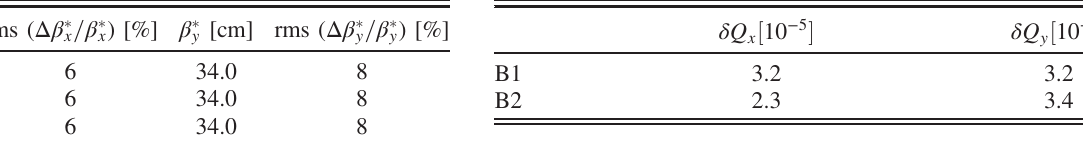
TABLE IV. Tune uncertainties during the MD carried out for vdM optics measurements.